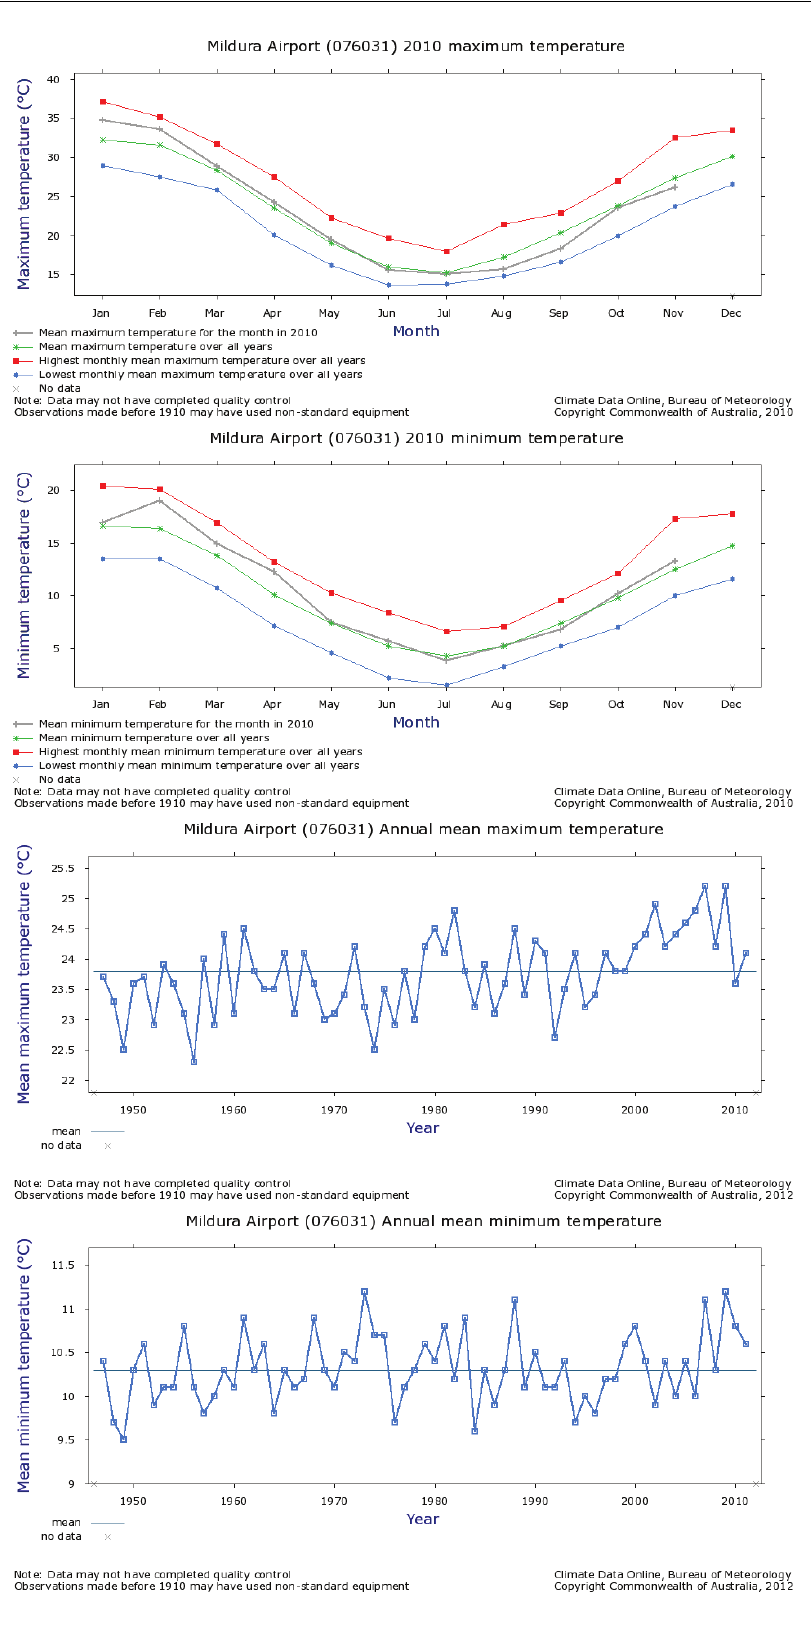
Figure 7. Australian Government Bureau of Meteorology temperature graphs for historical locations in Victoria, Aus- tralia. MILDURA AIRPORT. Site no.: 76031, Commenced: 1946, Latitude: 34.24 ı S, Longitude: 142.09 ı E, Elevation: 50